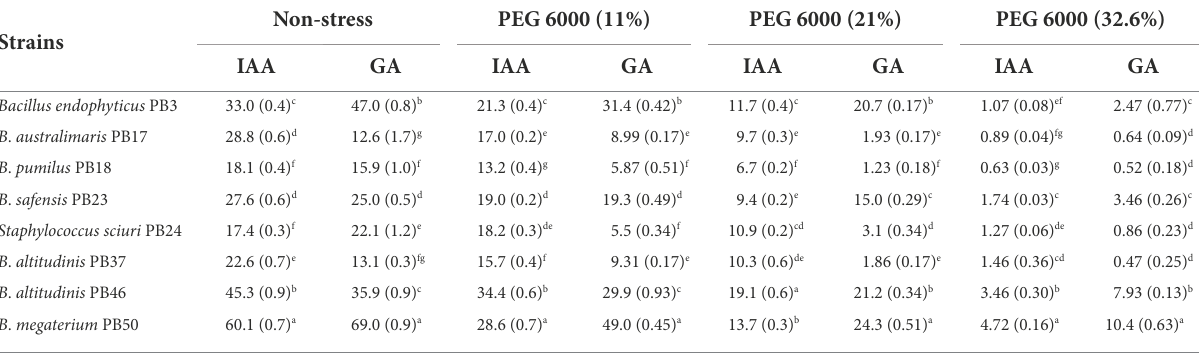
TABLE 4 Mean and standard deviation values of indole-acetic acid (IAA) and gibberellic acid (GA) production ( μ g ml − 1 ) by each rice phyllosphere bacterial strain (number of replicates, n = 3) measured under three different osmotic stress conditions and a non-stress condition.